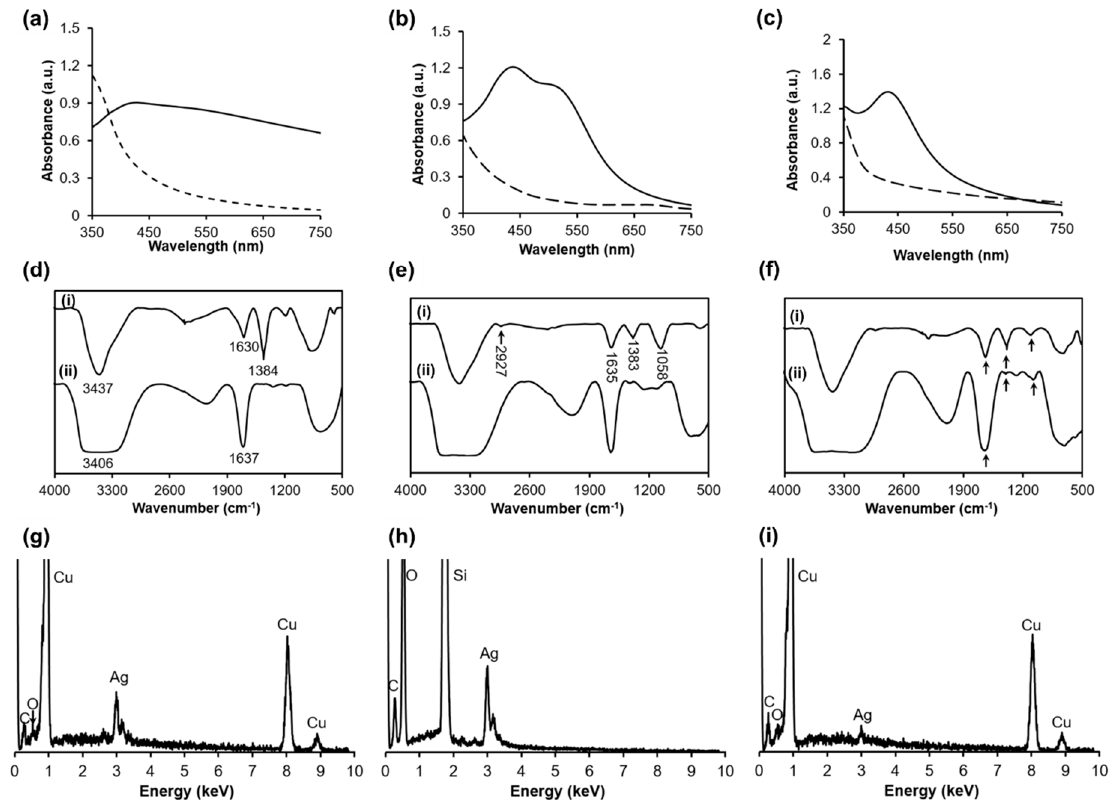
Figure 2. The UV-vis spectra of P.uri.ext and P.uri.AgNP ( a ), P.zey.ext and P.zey.AgNP ( b ), S.dul.ext and S.dul.AgNP ( c ), in which the dashed line is the spectra of extract, and the solid line is that of AgNP; the FTIR spectra of P.uri.ext and P.uri.AgNP ( d ), P.zey.ext and P.zey.AgNP ( e ), S.dul.ext and S.dul.AgNP ( f ), in which (i) line is the spectra of AgNP, (ii) line is the one of extract; the EDX spectra of P.uri.AgNP ( g ), P.zey.AgNP ( h ) and S.dul.AgNP ( i ).